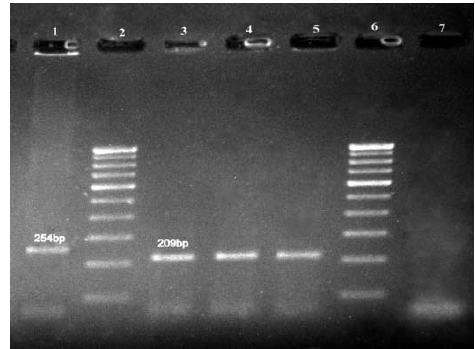
Fig. 1. Detection of virulence genes of E. coli